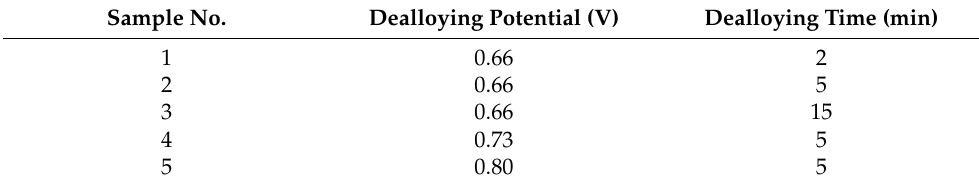
Table 1. Chemical dealloying parameters for the samples. Sample No.